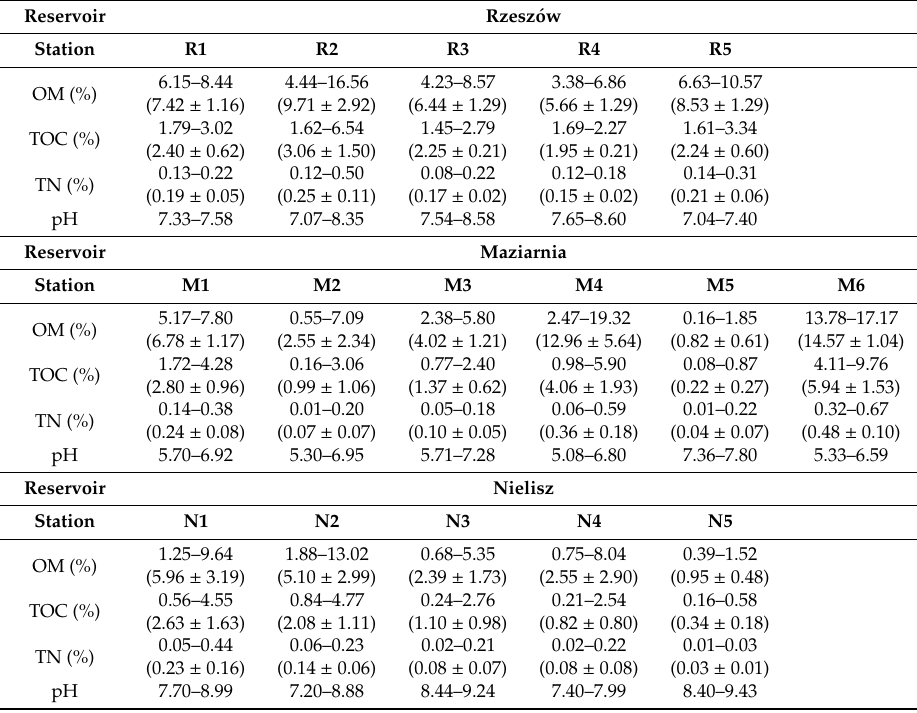
Table 1. Values for selected parameters characterizing sediments; min.–max. (mean ±